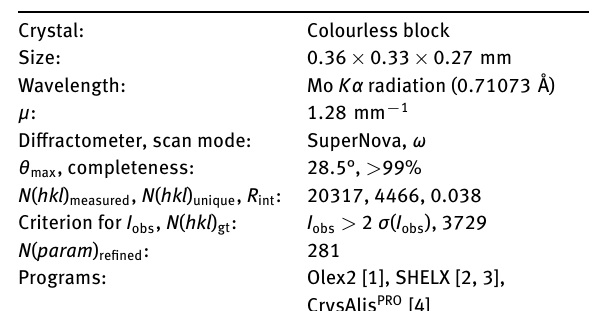
Table 1: Data collection and handling.